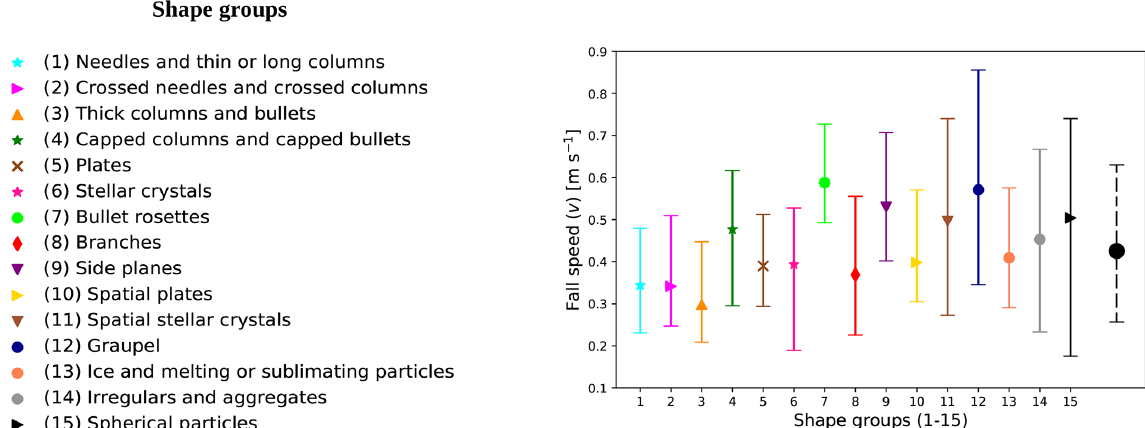
Figure 5. The fall speeds v of snow crystals for each shape group are shown in solid lines. The median and the distribution of v are shown. The values of the median are represented by points. The lower and upper ends of the vertical bars indicating the distributions are given by the 16th and 84th percentiles, respectively. These bounds would correspond to ± 1 σ (standard deviation) if the distribution was normal. For comparison, a dashed black line shows all data (regardless of shape). Table 2 contains a list of these percentiles and medians.